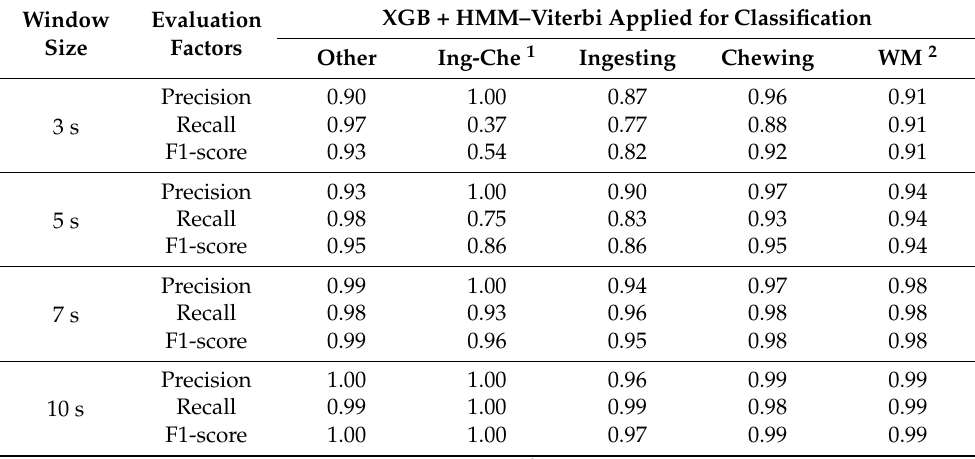
Table 5. Precision, recall, and F1-score for activity classification at different window sizes using XGB and HMM–Viterbi algorithm when accelerometer signals were sampled at the position of